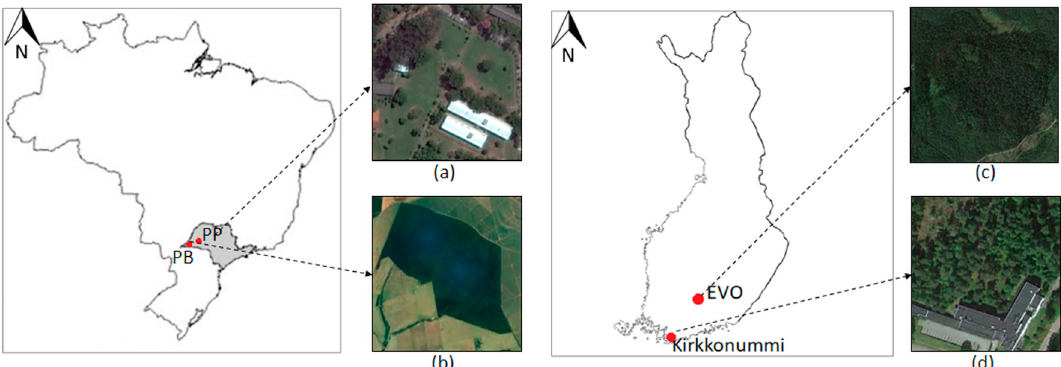
Figure 3. Test areas: ( a ) Test area I—UNESP campus at Presidente Prudente, São Paulo, Brazil; ( b ) Test area II—Ponte Branca at Euclides da Cunha, São Paulo, Brazil; ( c ) Test area IV—boreal forest at Evo, Finland; and ( d ) Test area III—FGI at Kirkkonummi,